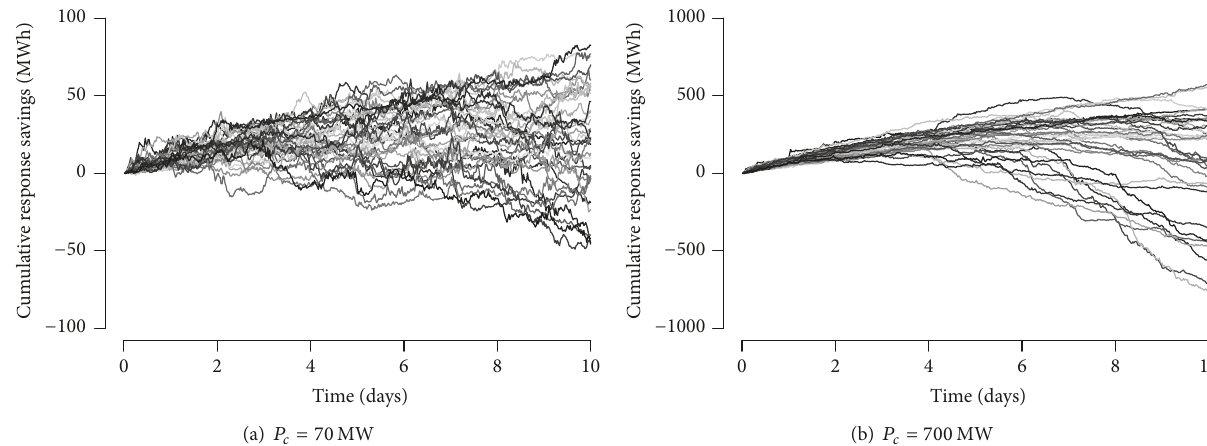
Figure 13: Cumulative response savings (MWh), the difference between other providers’ response with and without the frequency-sensitive fridge population (cumulatively) for the 36 data samples over one year for two different participation levels. We sum high frequency response and the absolute value of low frequency response, in MWh. Negative results indicate that the other providers had to compensate for detrimental fridge behaviour. In both cases the population is homogeneous.